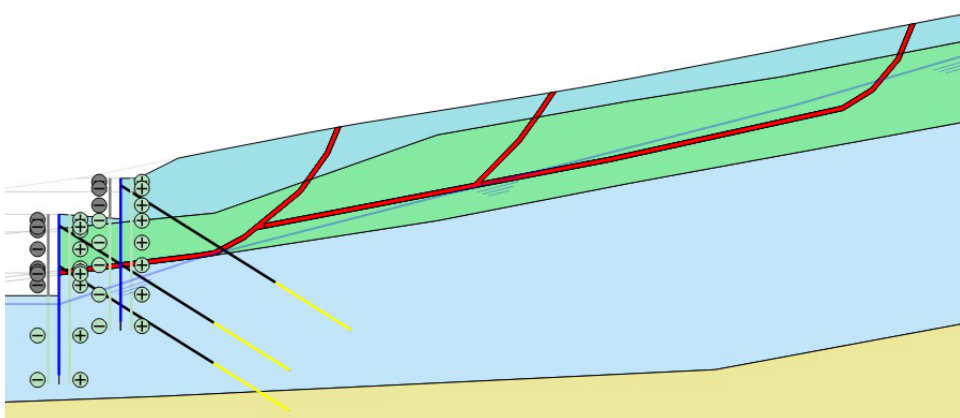
Figure 4. Geotechnical model at km 1.150–1.175 with three slip surfaces